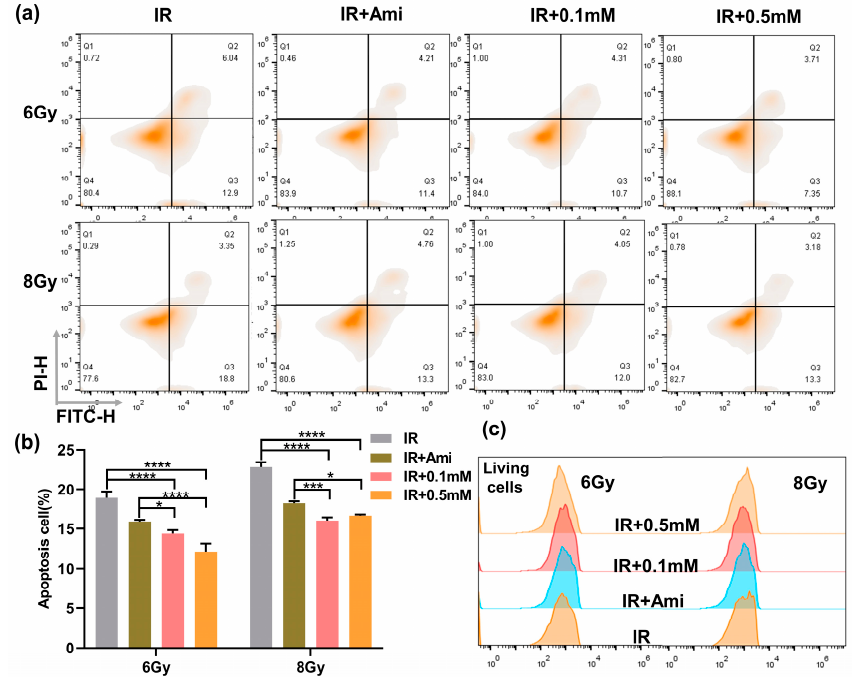
Figure 4. ( a ) Flow cytometry apoptosis analysis of HIEC-6 cells treated with groups of IR, IR + Ami, IR + 0.1 mM, and IR + 0.5 mM at 24 h after 6 and 8 Gy irradiation. ( b ) Living cells analysis from ( a ). ( c ) Quantitative analysis of apoptosis cells from Figure 4a. Results are presented as the mean ± SD in triplicate.